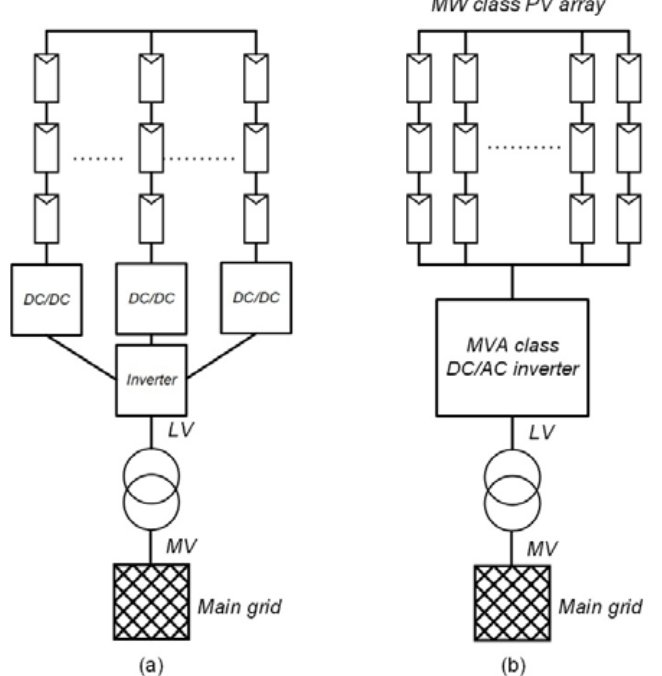
Figure 3. Configuration of PV inverter topologies ( a ) multistring ( b ) central.